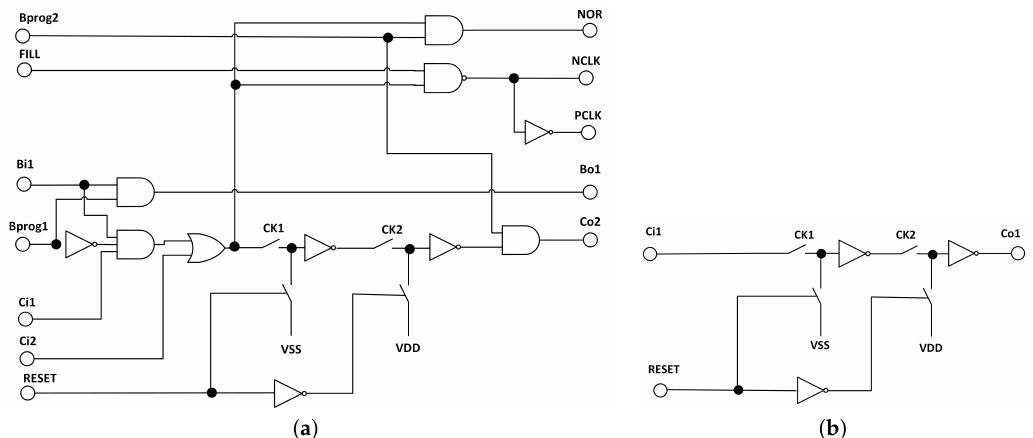
Figure 7. Diagrams of the ( a ) UCLK and ( b ) UCLK_IN sections used in the realized multi-phase